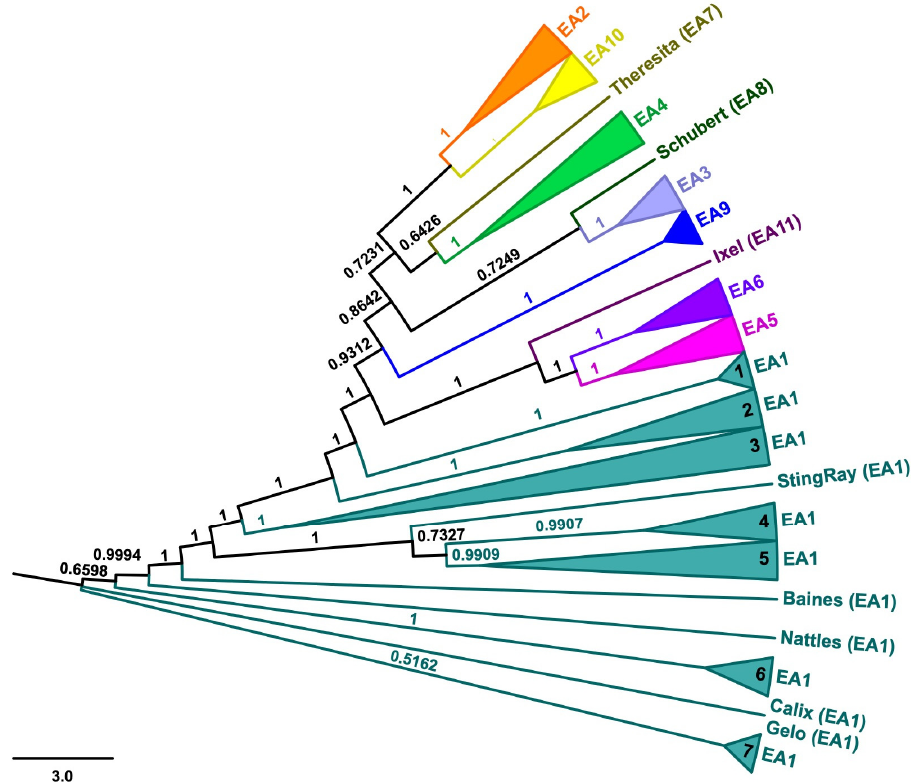
Figure 1. Neighbor-joining tree. Neighbor-joining tree generated using a multiple-sequence align- ment of 125 cluster EA bacteriophage genomes (Supplementary Table S1) with 10,000 bootstrap replicates. Colors highlight bacteriophage membership in sub-clusters EA1–EA11. Numbers on the branches indicate bootstrap